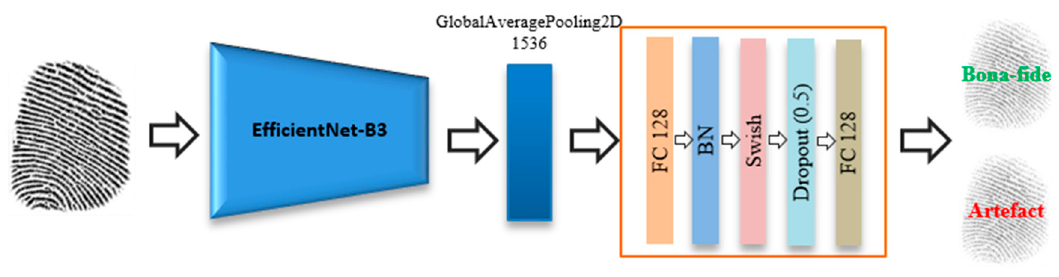
Figure 3. Flowchart of a fingerprint branch.